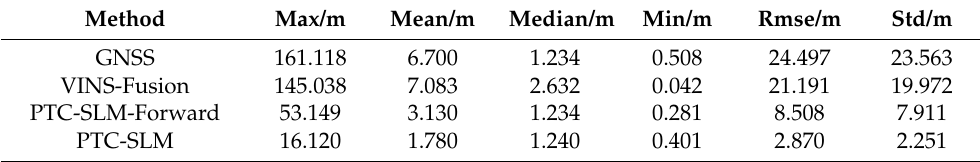
Table 7. Error parameters of the four methods in rural scene.